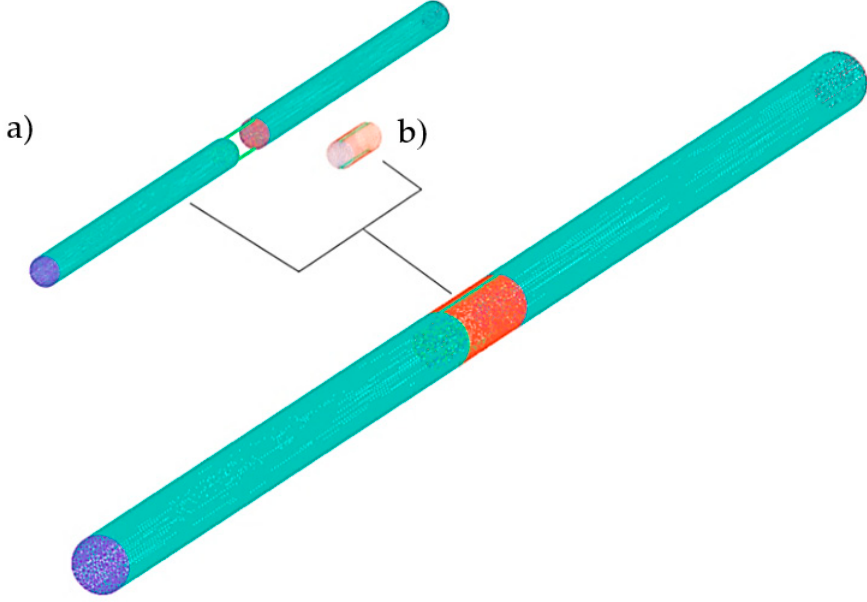
Figure 19. The numerical grid of the fluid ( a ) and the coal sample ( b ).